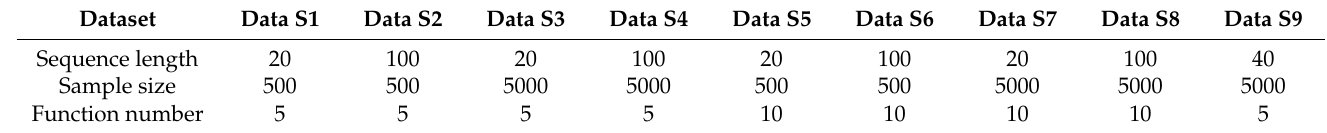
Table 1. Eight simulated datasets of varying sequence lengths, sample sizes, and function